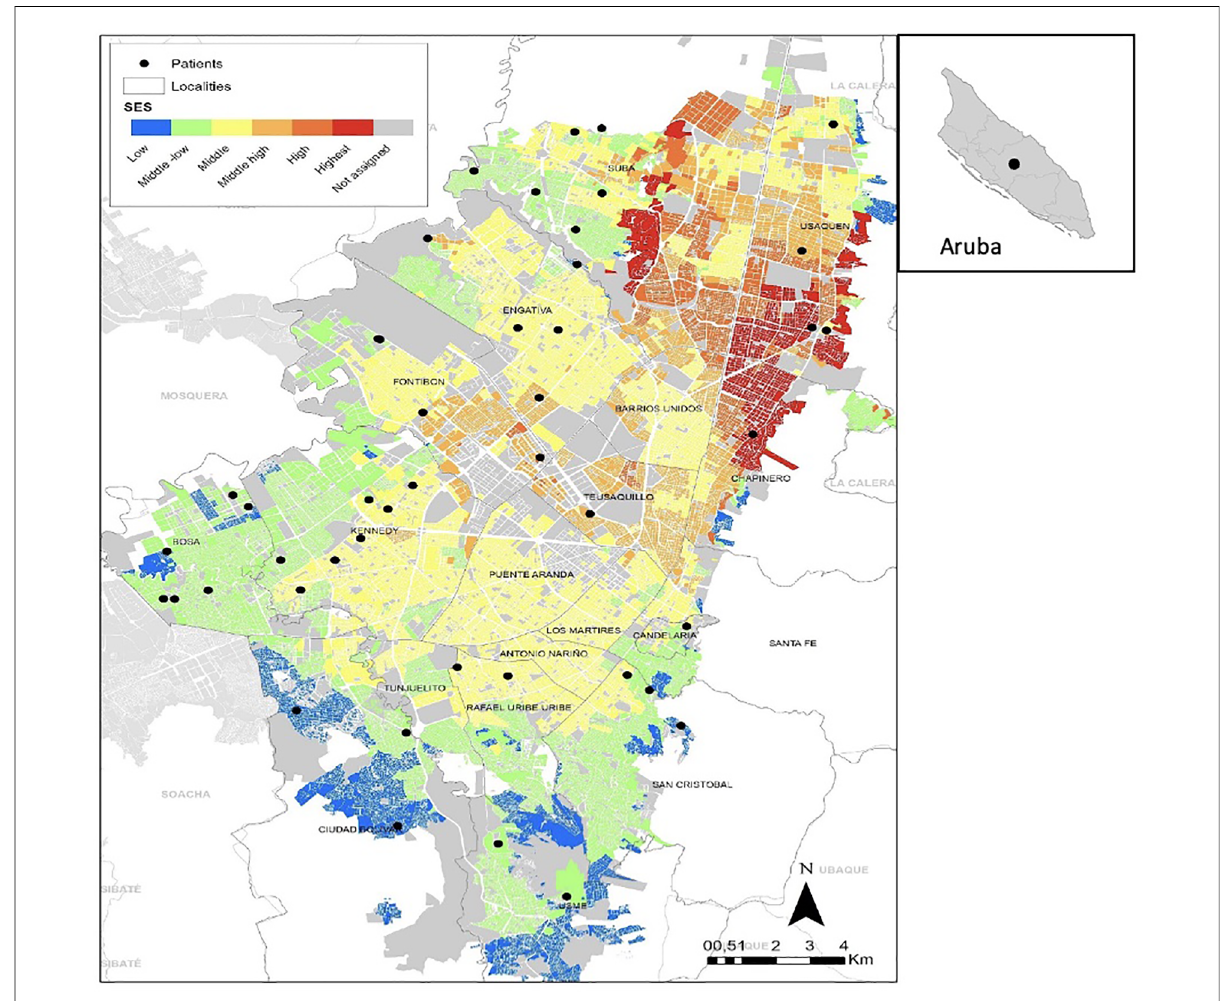
FIGURE 2 Distribution of housing in bogota by location and socioeconomic Strata and foreing